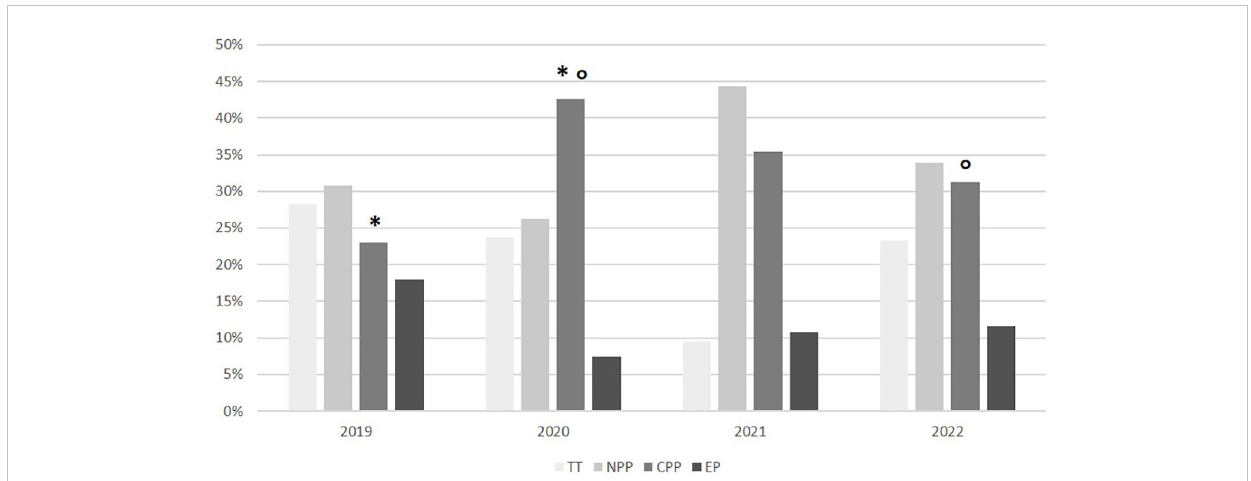
FIGURE 2 Subgroup distribution according on the fi nal diagnosis in the different years. TT, transient thelarche; NPP, non-progressive precocious puberty; CPP, central precocious puberty; EP, early puberty. *p<0.01;